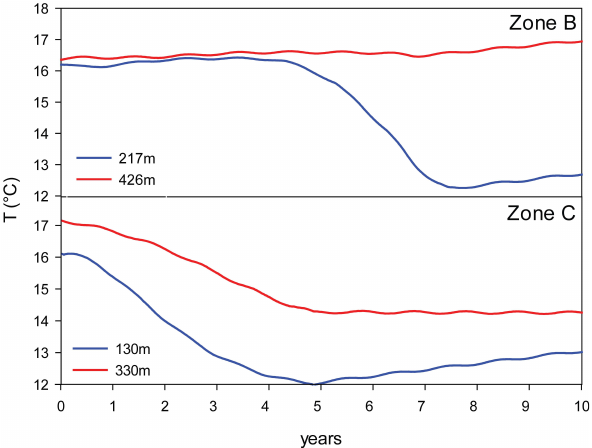
Fig. 12. Development of temperatures down-gradient of new groundwater use for heating for zones B and C (for locations see Figs. 1 and